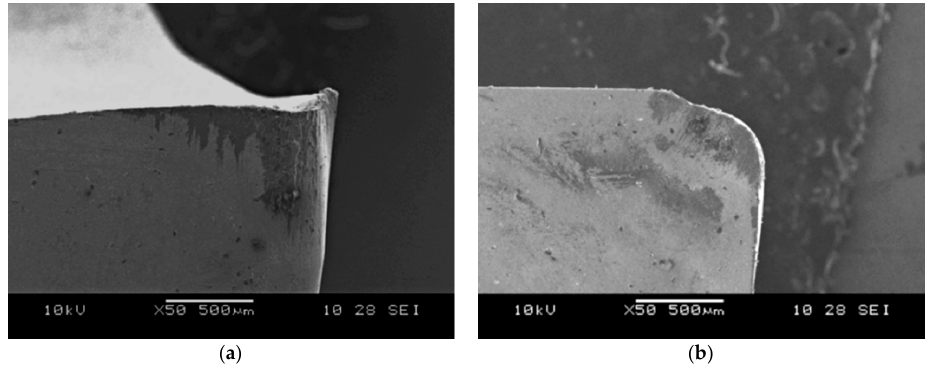
Figure 12. SEM image of DCGW PCBN cutting edge after composite machining, wear by accumulations: ( a ) side view; ( b ) top view.